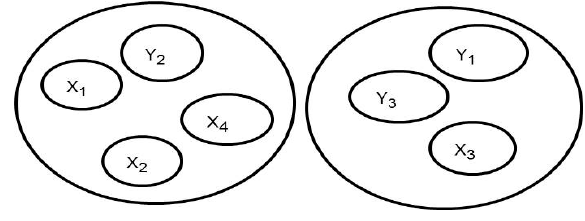
Figure 4. Clustering configuration example.